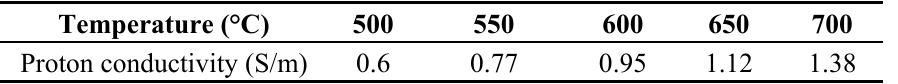
Table 2. Proton conductivity of the electrolyte at different operating temperatures.